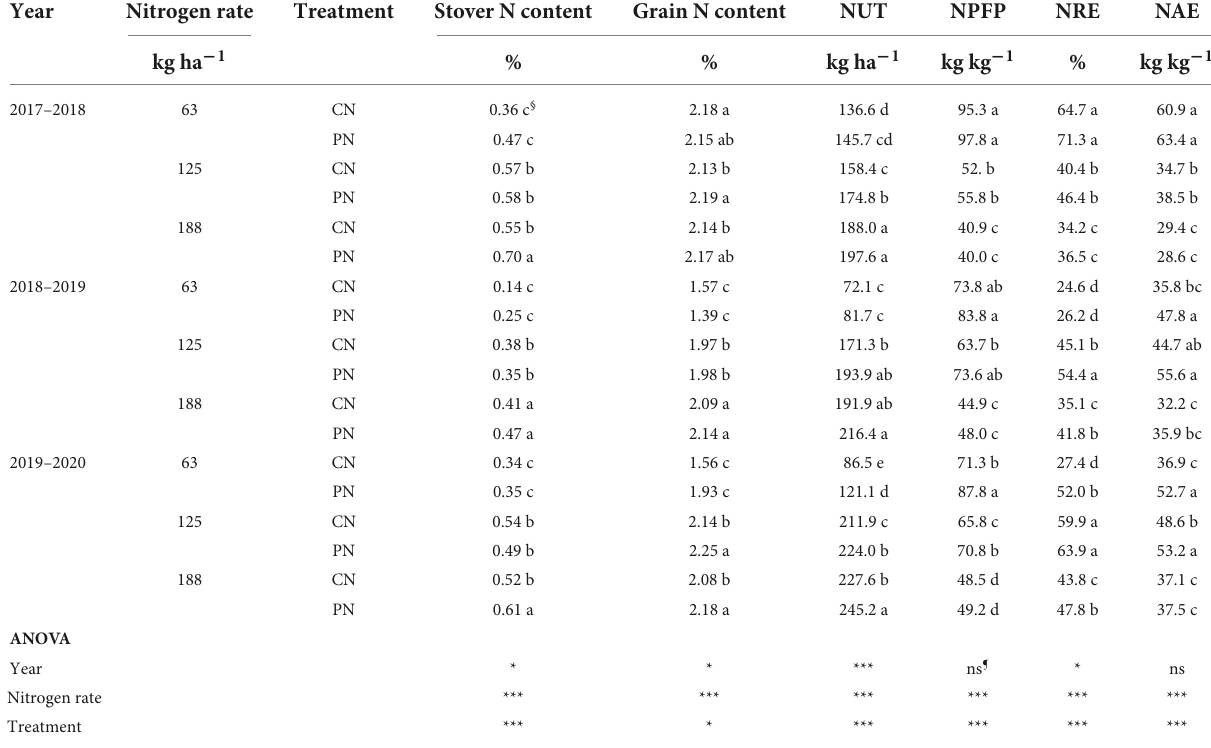
Year Nitrogen rate Treatment Stover N